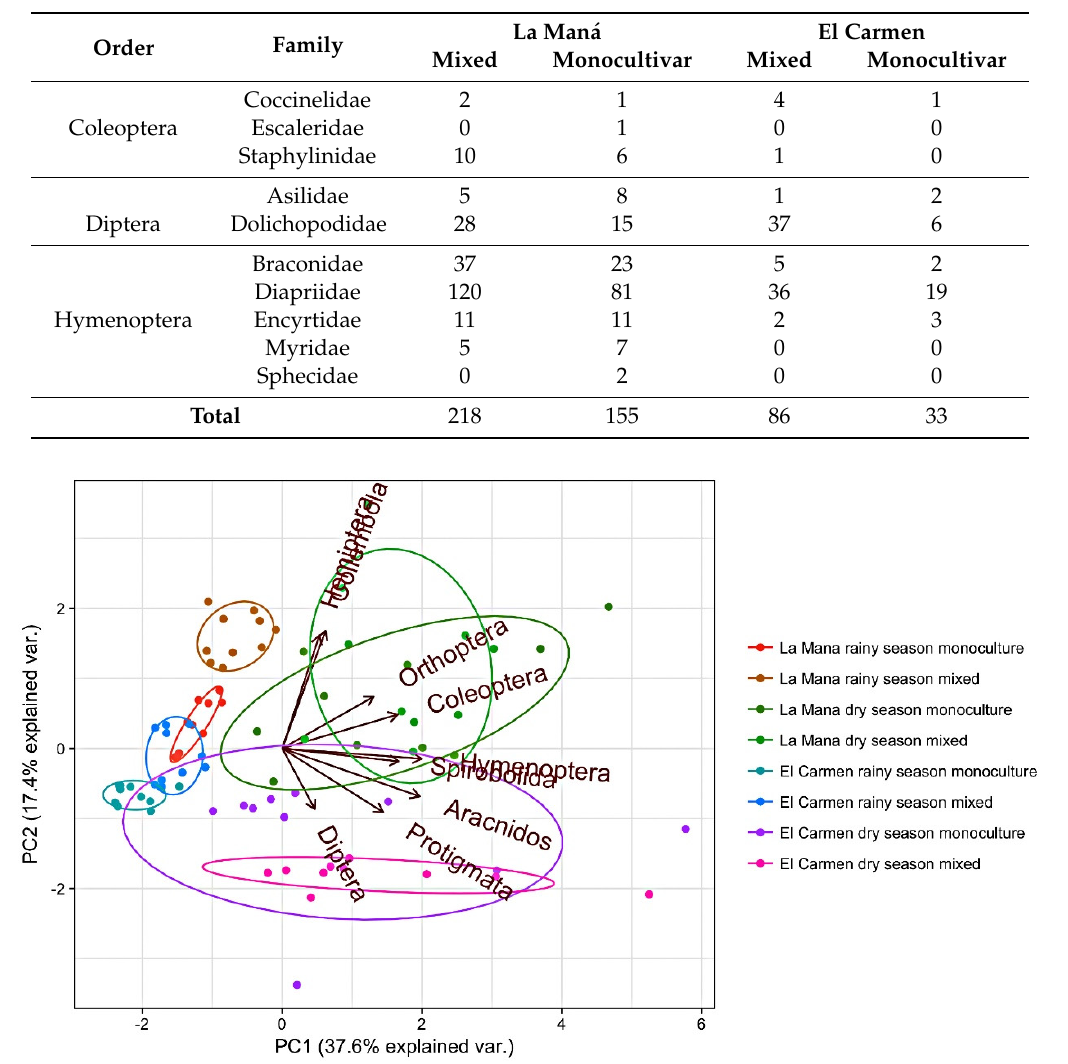
Table 9. Number of beneficial arthropods found in the di ff erent agroecosystems and sites.